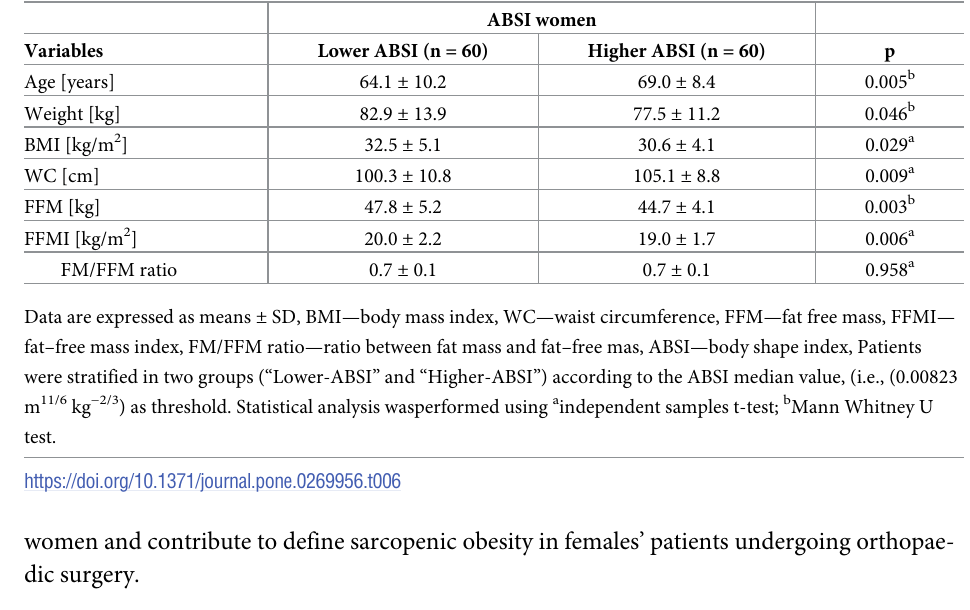
women and contribute to define sarcopenic obesity in females’ patients undergoing orthopae-